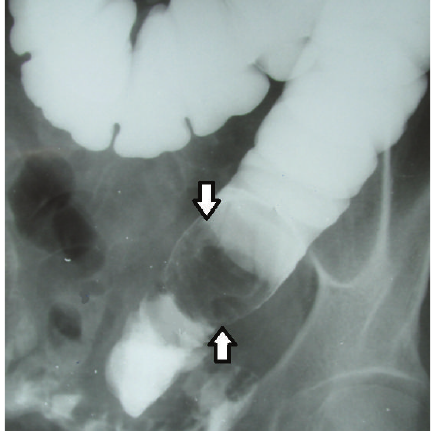
Figure 2: Endoluminal filling defect in barium enema